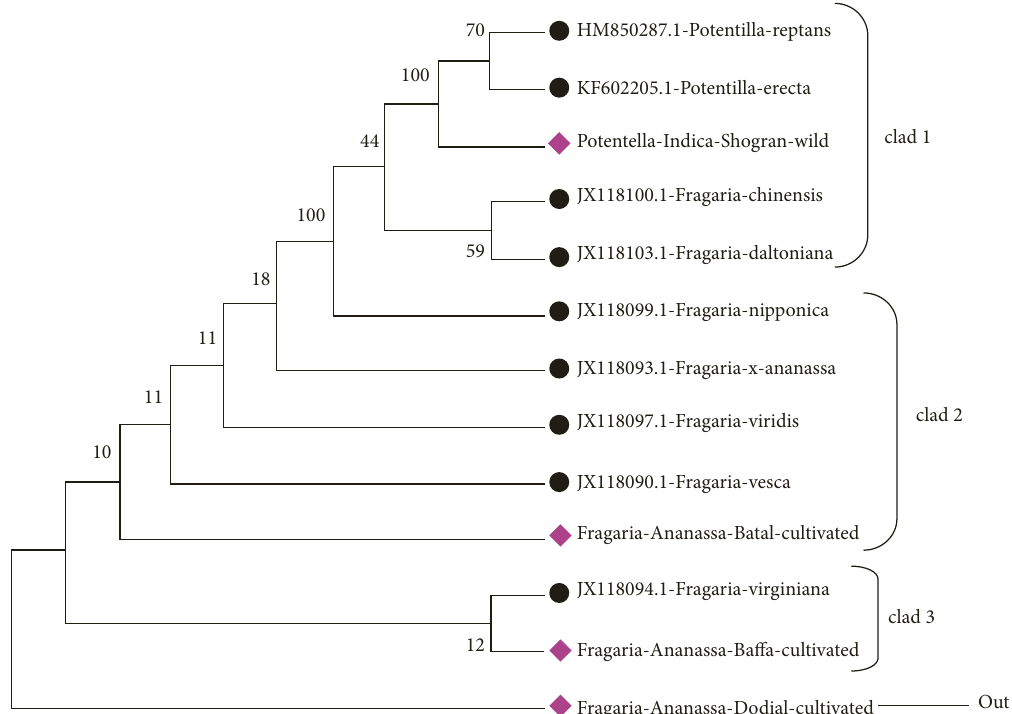
Figure 17: Phylogenetic tree analysis of the Fragaria species ( rbclC ) marker with related reference species through the maximum parsimony